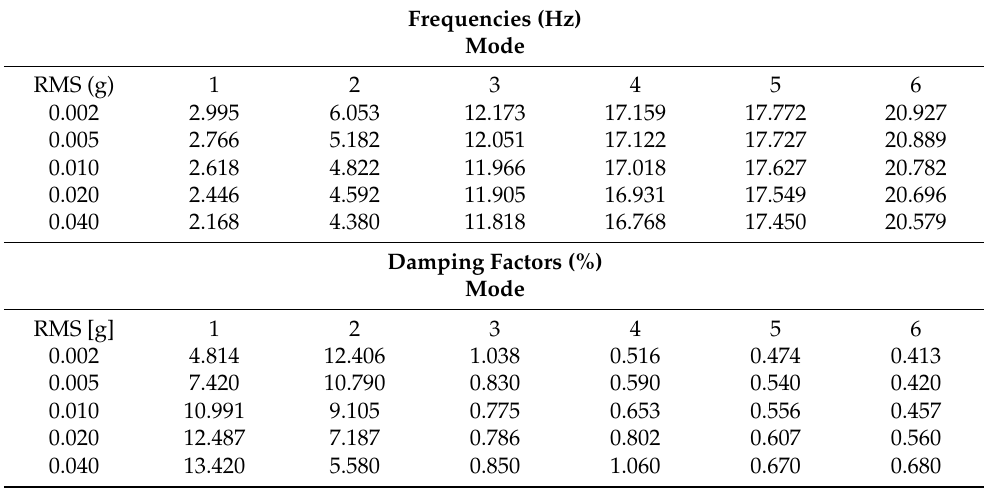
Table 4. FTMD—identified frequencies and damping factors varying input